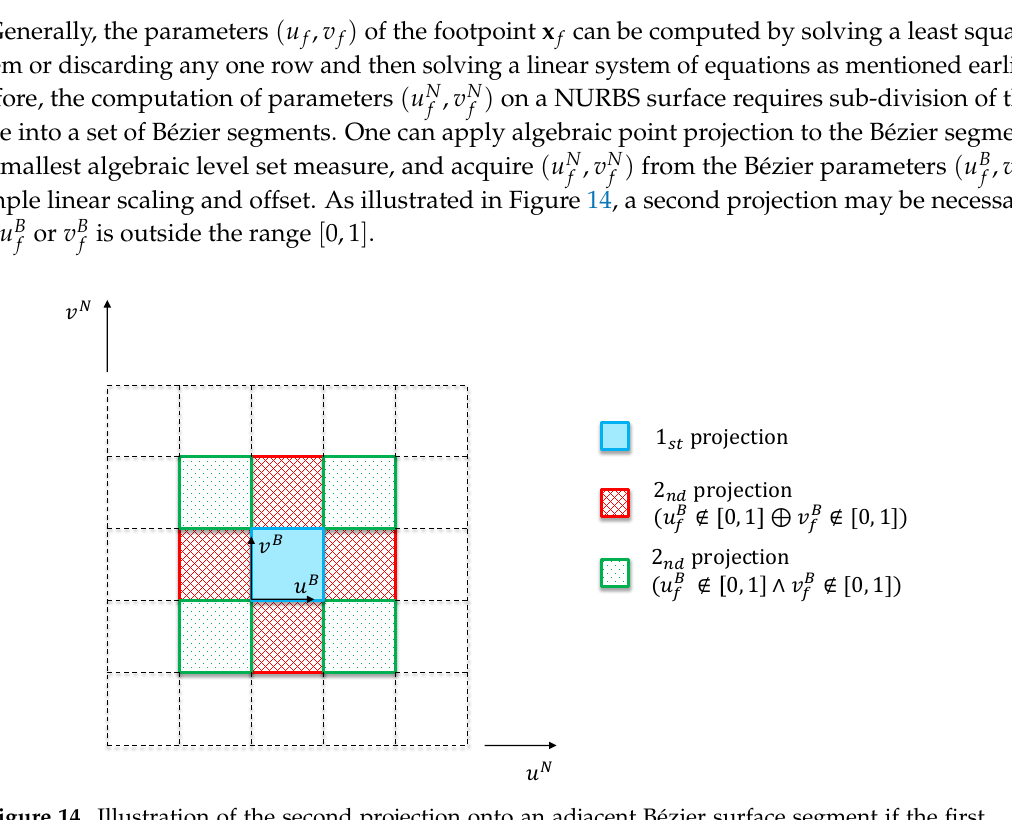
Figure 14. Illustration of the second projection onto an adjacent Bézier surface segment if the first projection yields an out-of-span